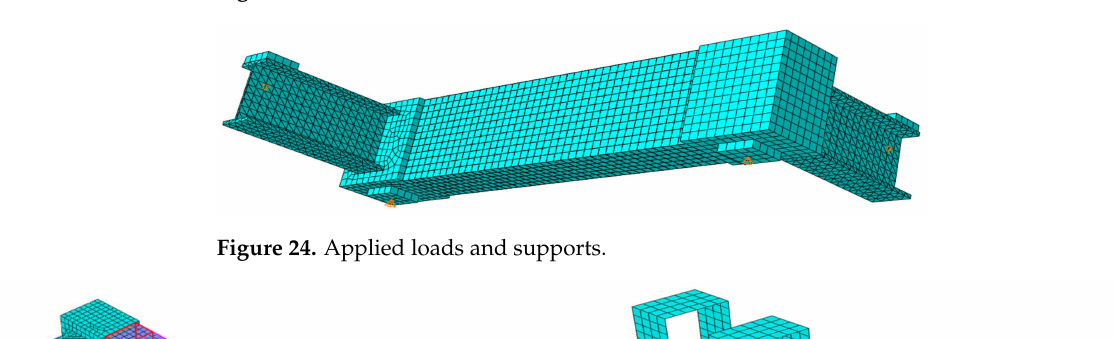
Figure 23. Meshes of beam B0-Control.